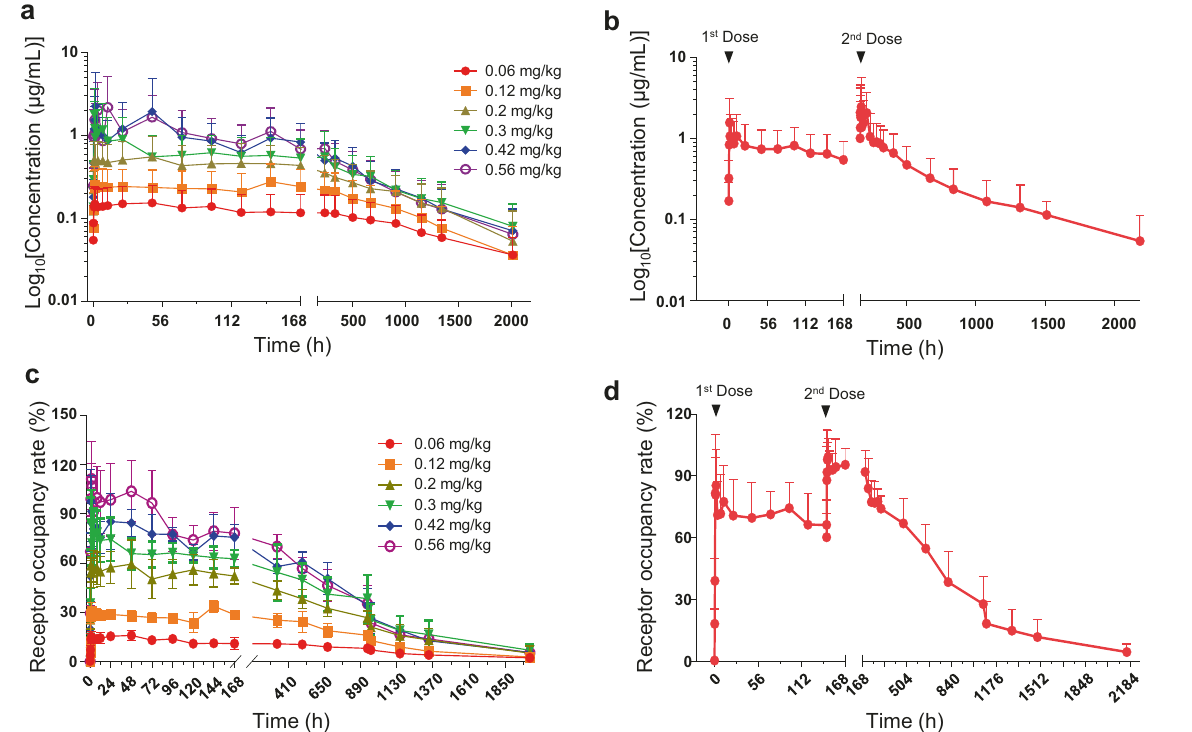
Fig. 2 a Mean drug concentration – time pro fi le on peripheral blood cells of healthy subjects in single-dose cohorts; b mean drug concentration – time pro fi le on peripheral blood cells of healthy subjects in the multiple-dose cohort; c mean RO%-time pro fi le on peripheral blood cells of healthy subjects in single-dose cohorts; d mean RO% – time pro fi le on peripheral blood cells of healthy subjects in the multiple- dose cohort. Means and standard deviations are presented